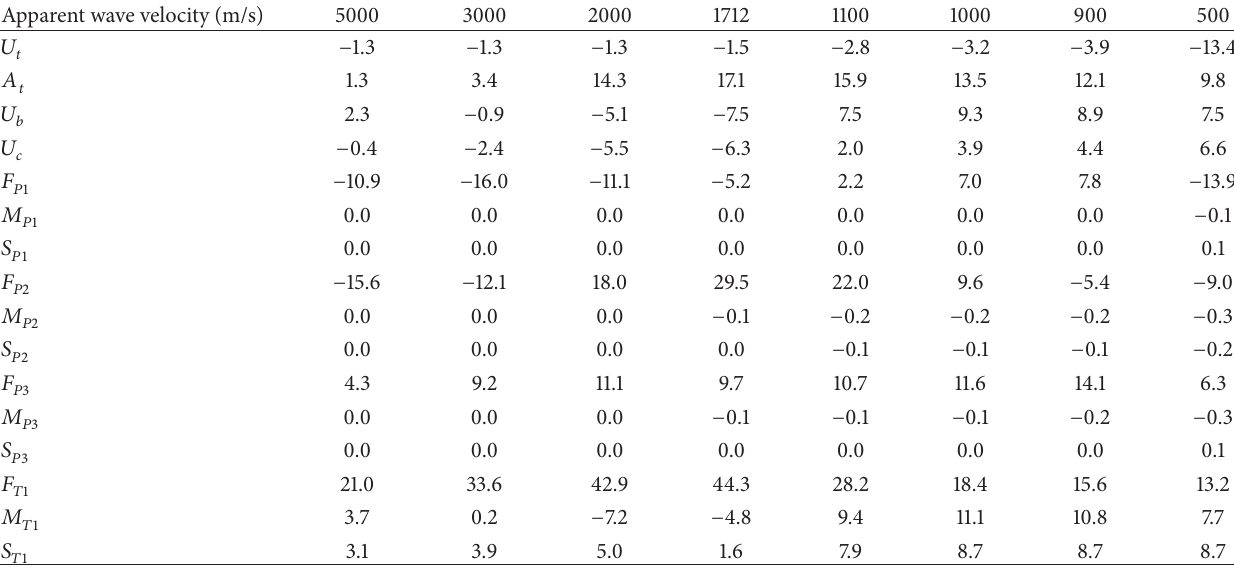
Table 5: Traveling wave effect influence coefficient (%) for seismic responses under excitation of 𝑐 1 . Apparent wave velocity (m/s)